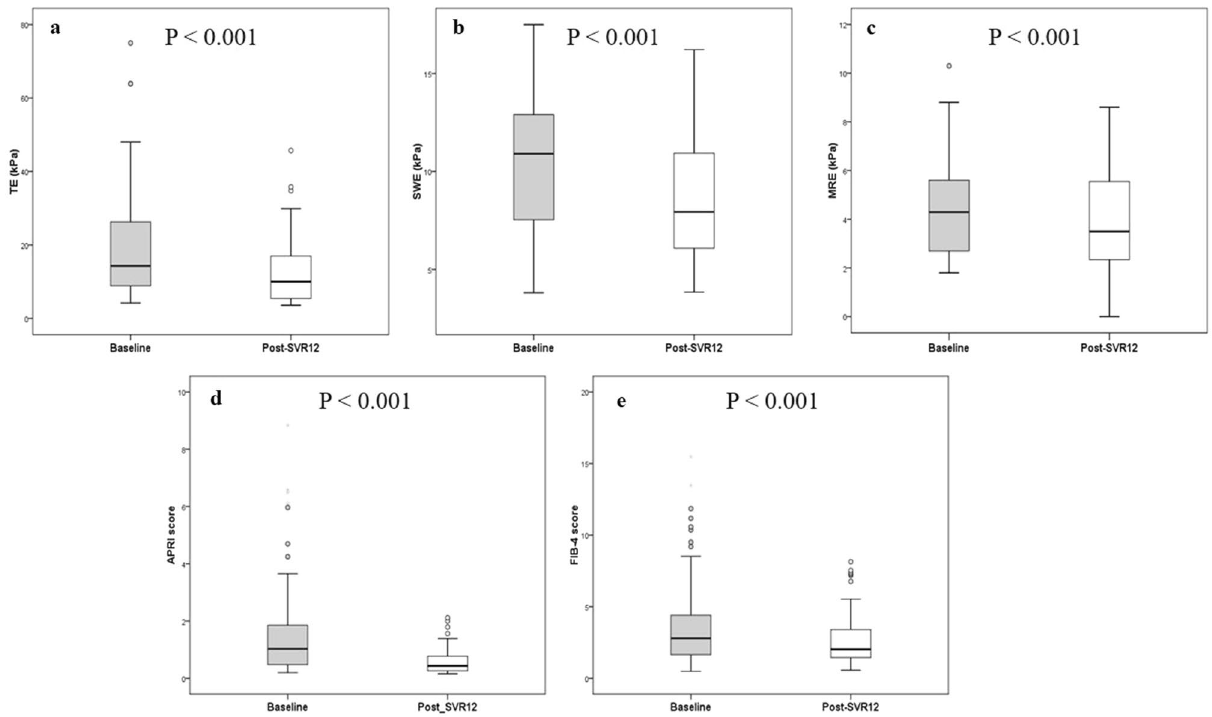
Figure 4. Liver stiffness values, APRI and FIB-4 scores at baseline and post-SVR 12 in chronic HCV patients with SVR after DAA treatment.